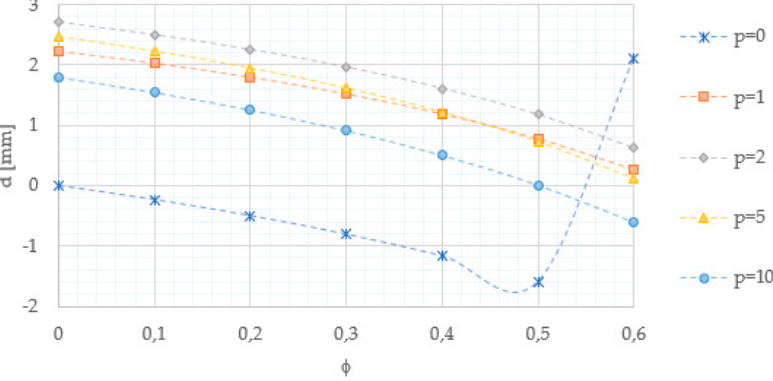
Figure 9. Porosity distribution model M1: evolution of neutral surface shift.